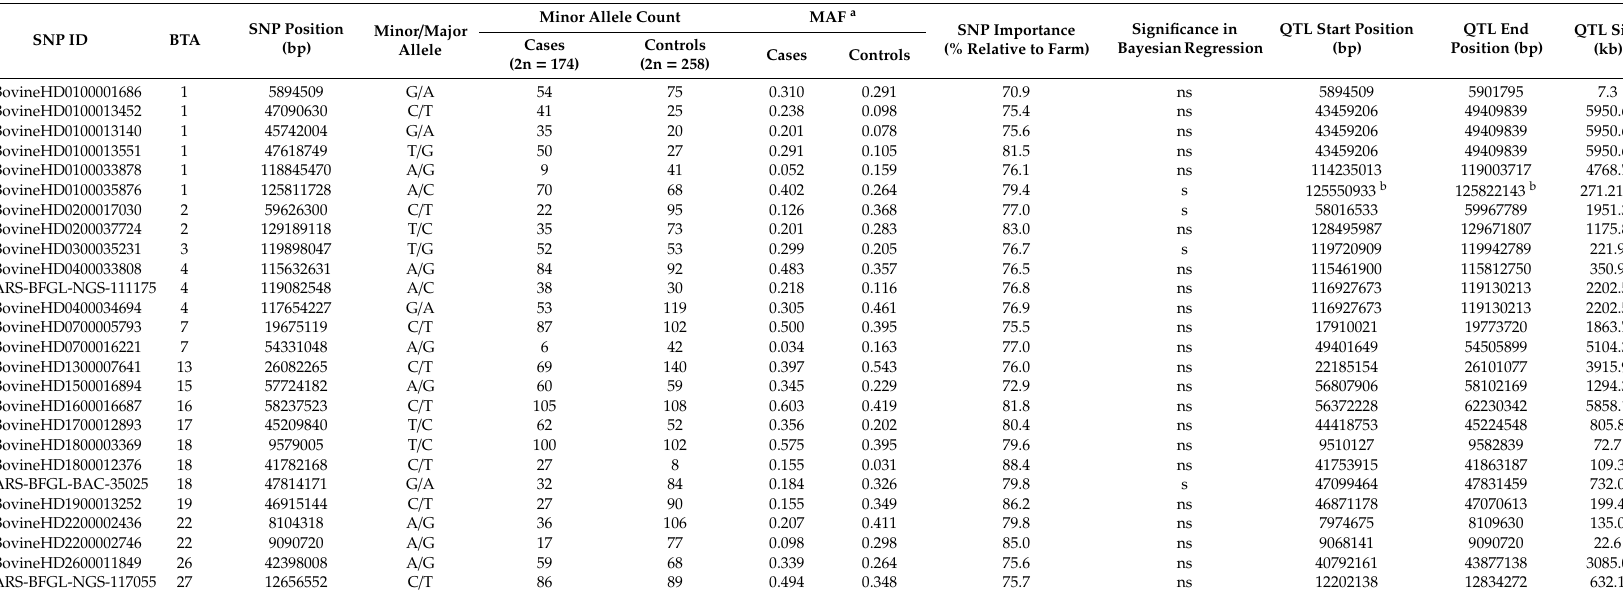
Table 3. Important SNPs from random forest analysis using binary phenotypes and their defined QTL. Importance variables are expressed as % importance relative to farm (i.e., farm was 100%